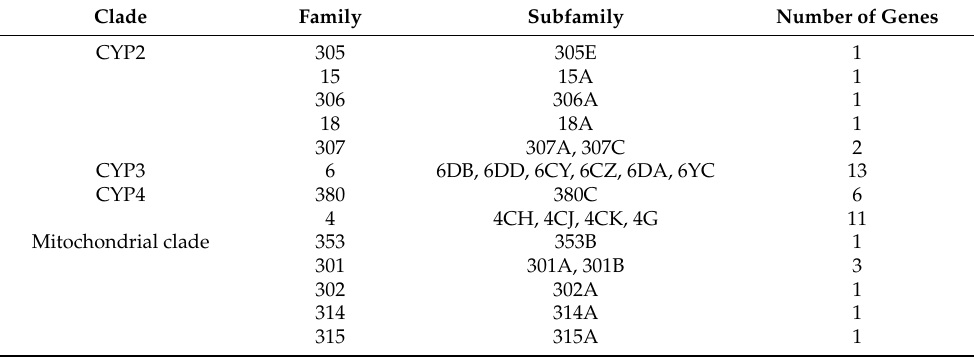
Table 1. Family and subfamily of P450 genes in Pseudoregma bambucicola